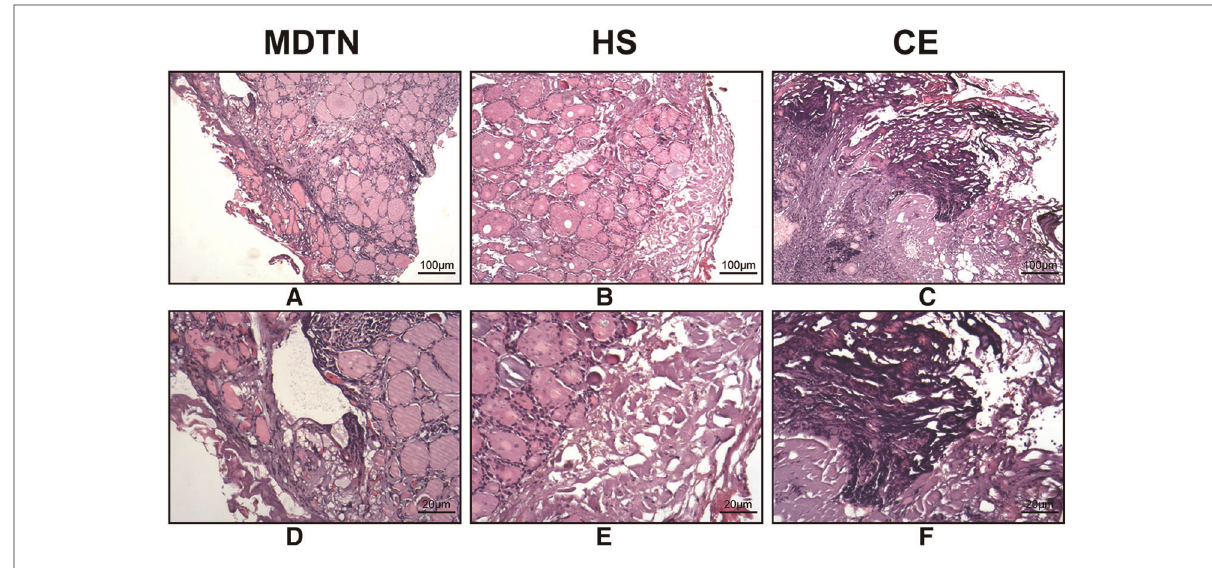
FIGURE 3 Histological sections (H&E staining) of the surgical margins of thyroid specimens from the three groups. The scale bars were included in the fi gures. ( A,B ) MDTN group; ( C,D ) HS group; ( E,F ) CE